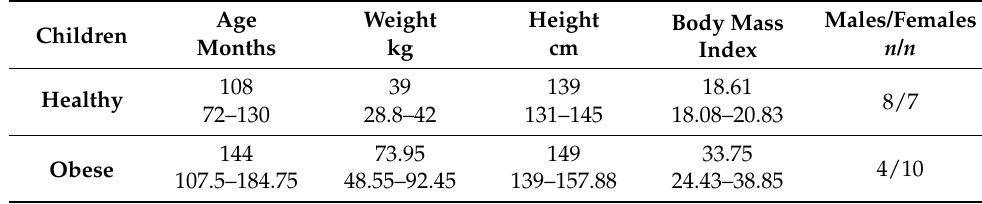
Table 1. Demographic data of enrolled